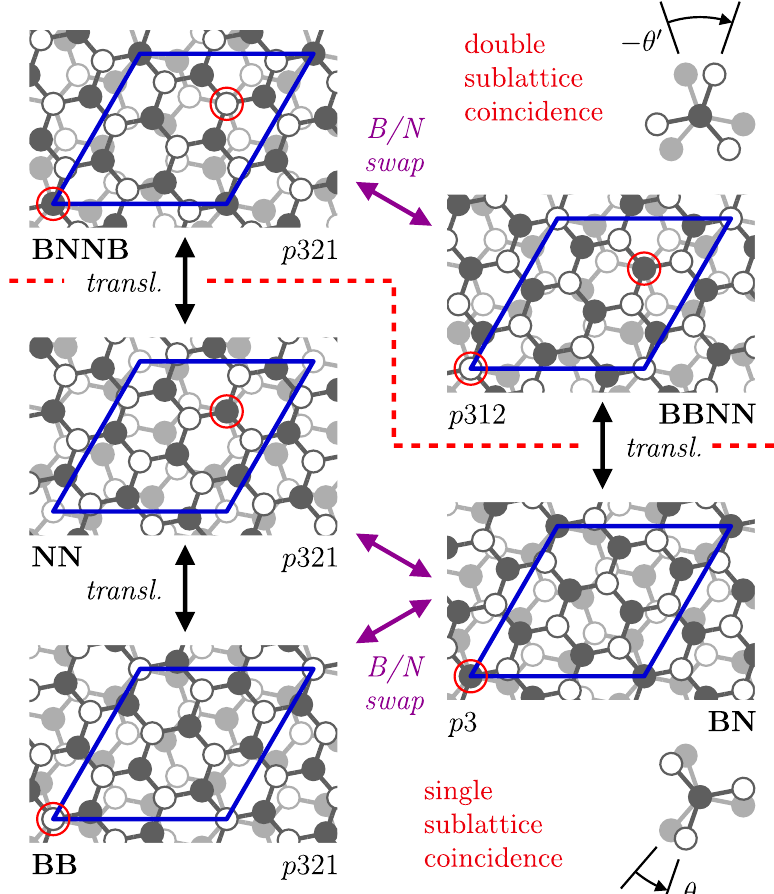
Figure 2: The five stackings of hBN moiré structures, with p = 2 and q = 1. The sub- lattice coincidences are highlighted with red circles. The reported symmetry groups are for twisted bilayers (untwisted bilayers have different symmetry